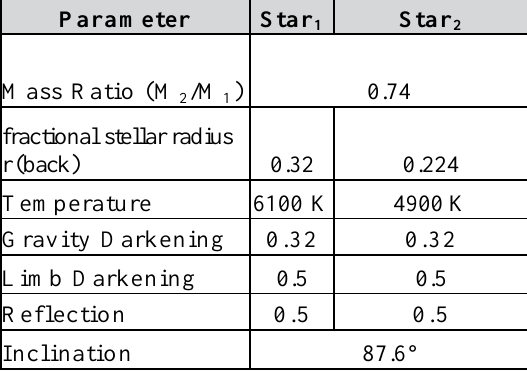
Table3: the light curve fit parameters for RT And.